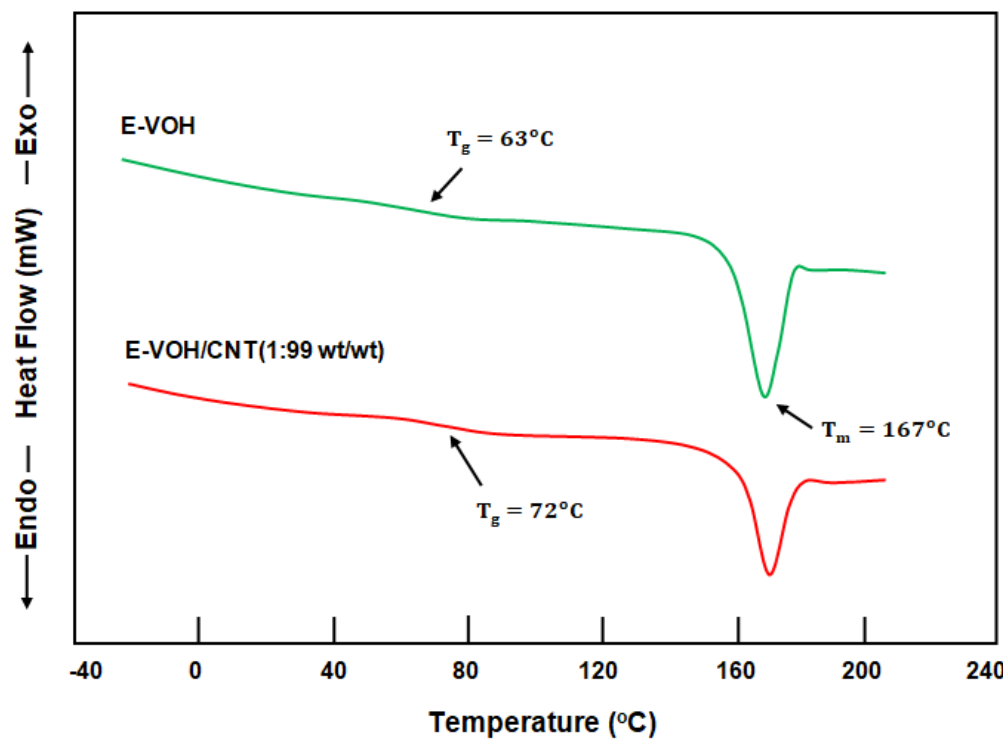
Figure2. Di ff erentialscanningcalorimetry(DSC)thermogramsofE-VOHandE-VOH / Figure 2. Differential scanning calorimetry (DSC) thermograms of E-VOH and E-VOH/CNT membranes.